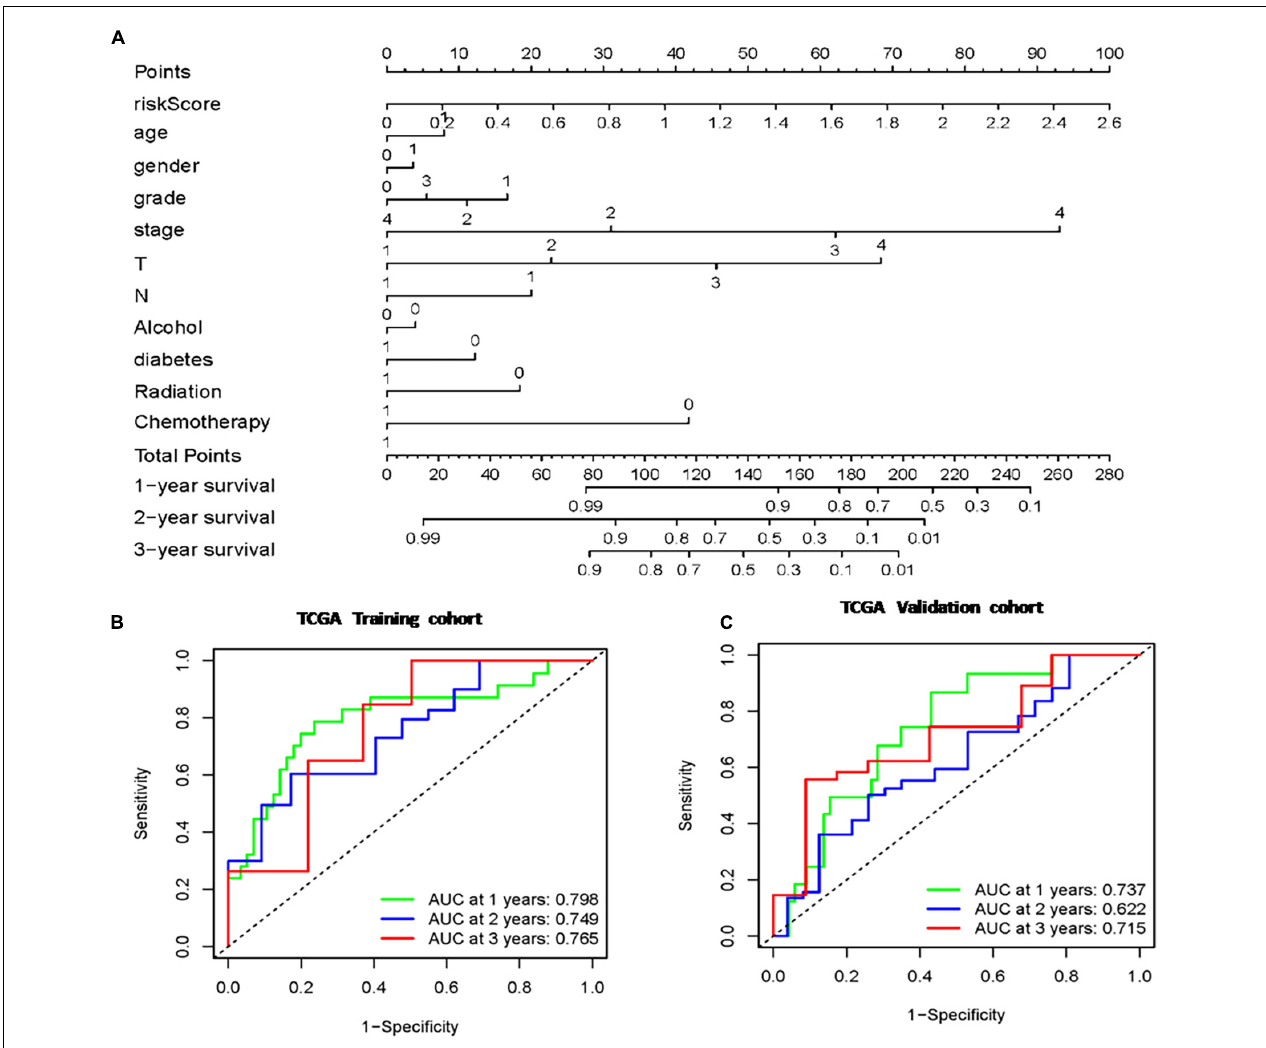
FIGURE 4 | Nomogram based on risk score of m6A-lncRNA signature and clinicopathological manifestation. (A) The nomogram predicts the probability of the 1-, 2-, and 3-year OS. (B) The ROC of the TCGA training cohort (C) The ROC of the TCGA validation cohort.